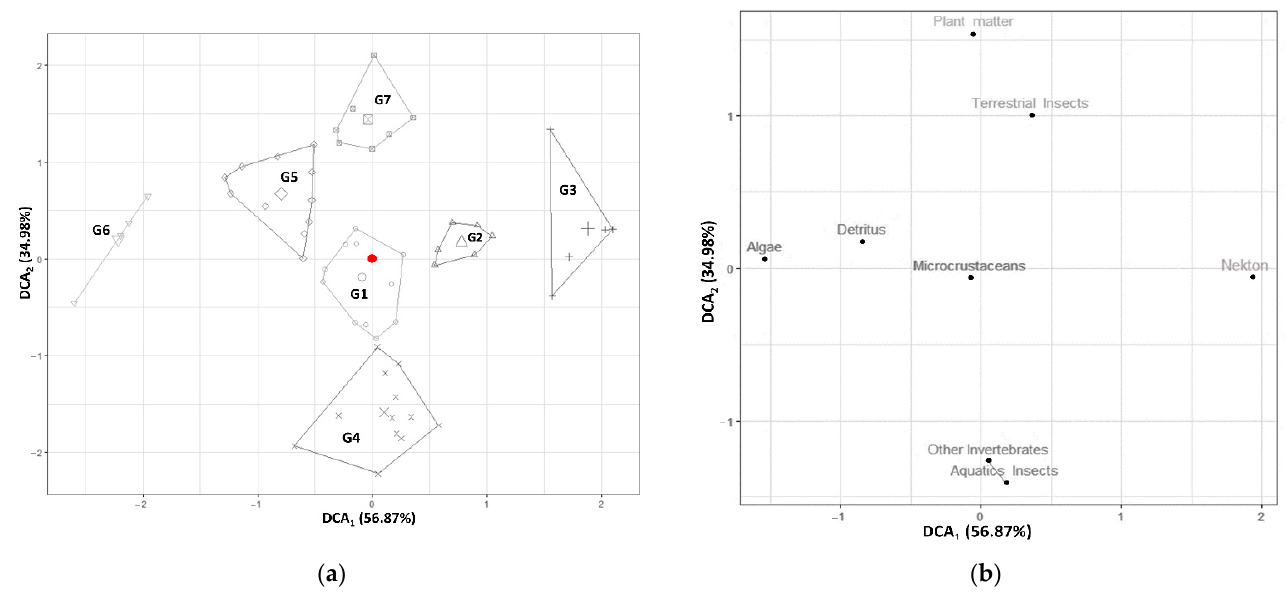
Figure 3. Ordination map of the standardized detrended correspondence analysis (DCA) for ( a ) the trophic guild groups (G1–G7), and ( b ) prey types of the Greek freshwater fish species resulting from the k-means the clustering optimization routines (DCA 1 : 56.87%; DCA 2 : 34.98%; N = 60). The red circle indicates the centroid of the ordination analysis (G1: zooplanktivorous; G2: opportunistic piscivorous; G3: piscivorous, G4: insectivorous; G5: opportunistic zooplanktivorous; G6: herbivorous; G7: opportunistic detritivorous). Table 2. Cluster metrics obtained from the average silhouette and the gap statistic method via 999 Monte Carlo simulations for the determination of the optimal number of clusters (ˆ k = 7) in the Greek freshwater icthyofauna based on their diet composition.